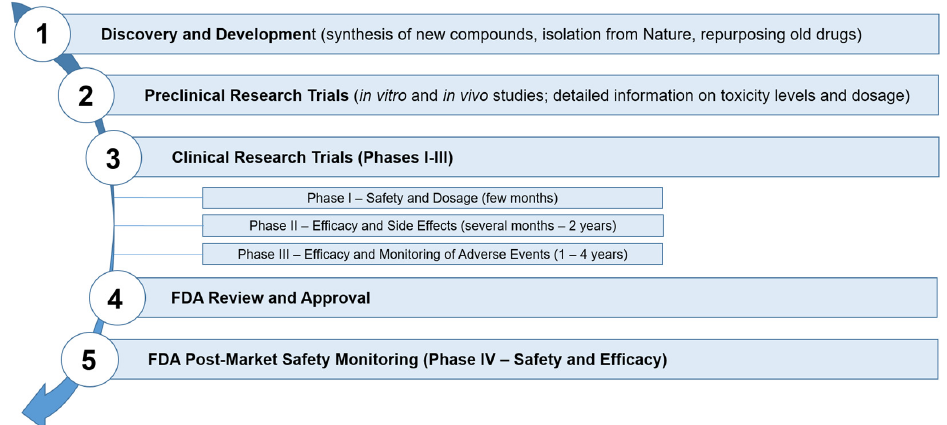
Figure 8. A flowchart representing the drug development process [own drawing].